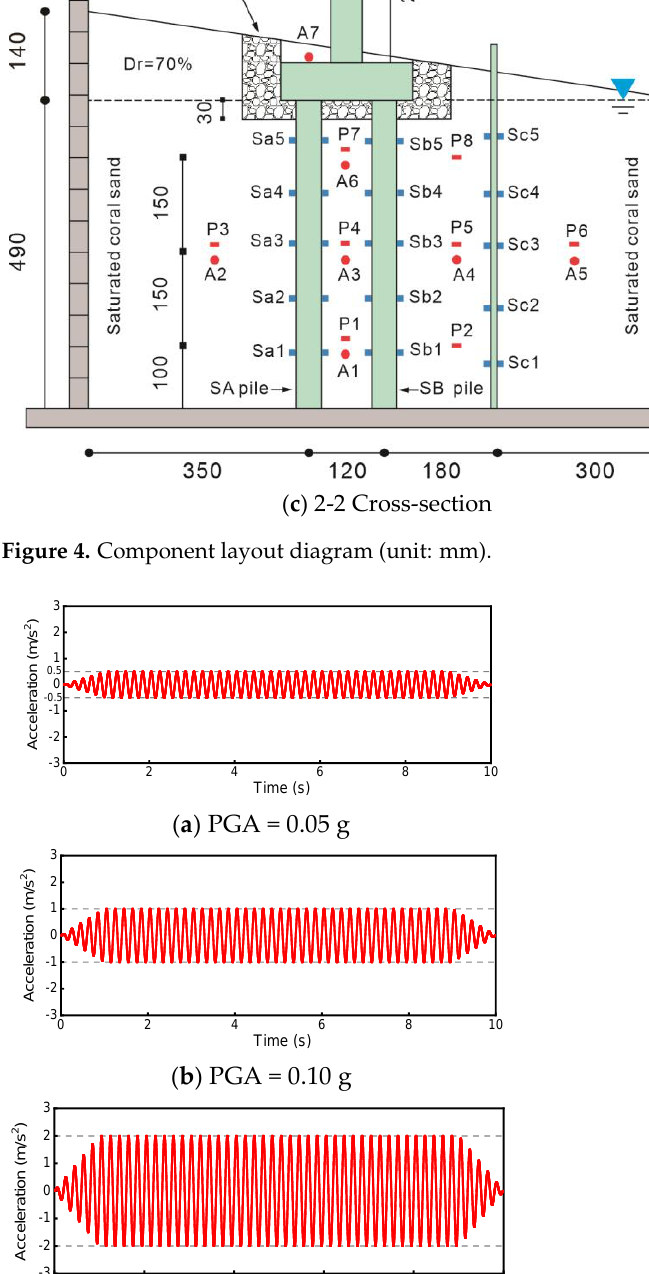
Table 5. Loading sequence and test programs of the model test.